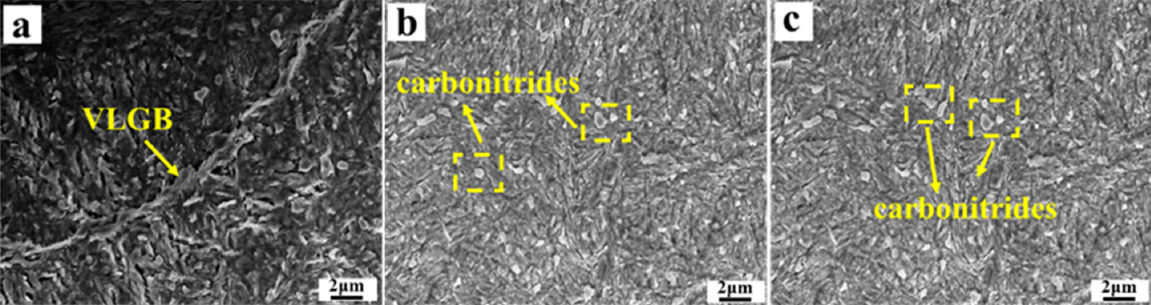
Figure 11. ( a – c ) shows the microstructure at the same distance of 225 µm from the surface in the di ff usion layers of C + 100P, 200P, and 300P + N, respectively.